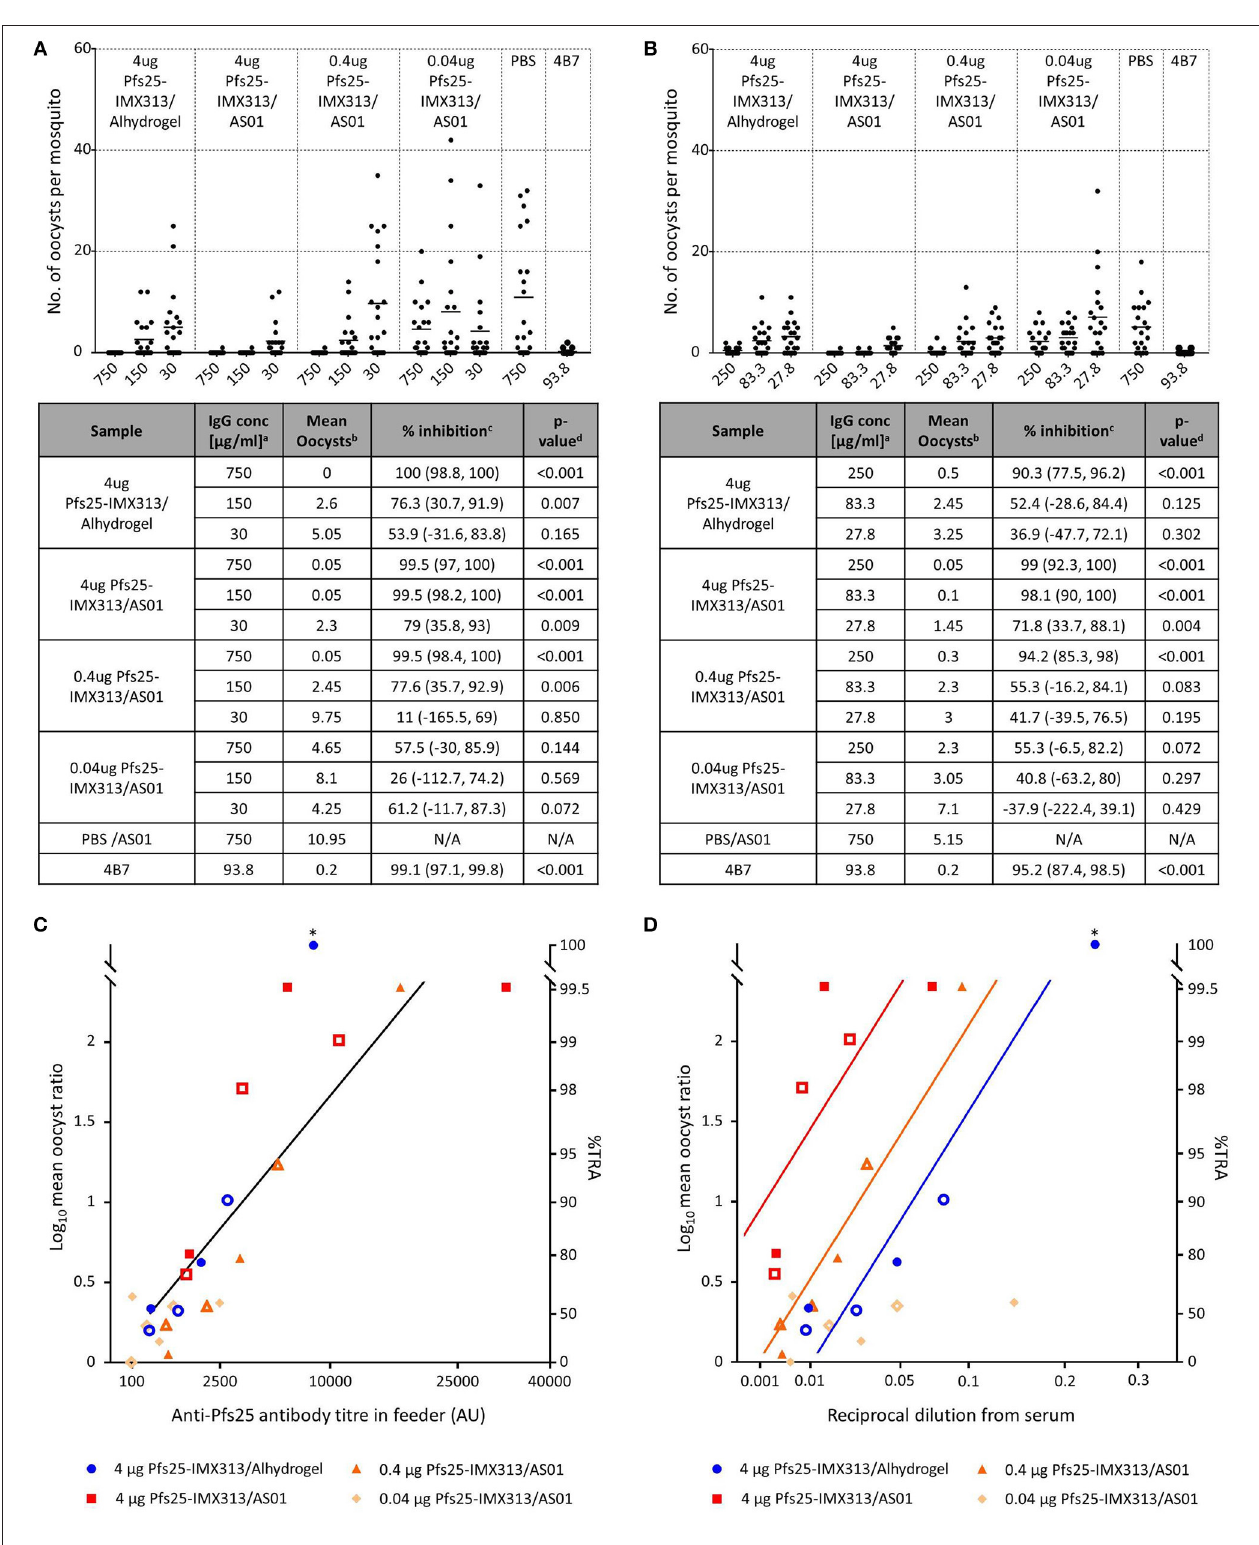
FIGURE 2 | Transmission blocking activity of anti Pfs25-IgG induced by immunization with Pfs25-IMX313 in Alhydrogel or AS01. (A,B) Total IgG, purified from pooled serum of each group (2 weeks post boost) was tested in SMFA in two independent experiments, one using total IgG concentrations of 750, 150 and 30 µ g/ml (A) and one using total IgG concentrations of 250, 83.3, and 27.7 µ g/ml (B) . The transmission blocking monoclonal anti-Pfs25 antibody 4B7 was used as a positive control.